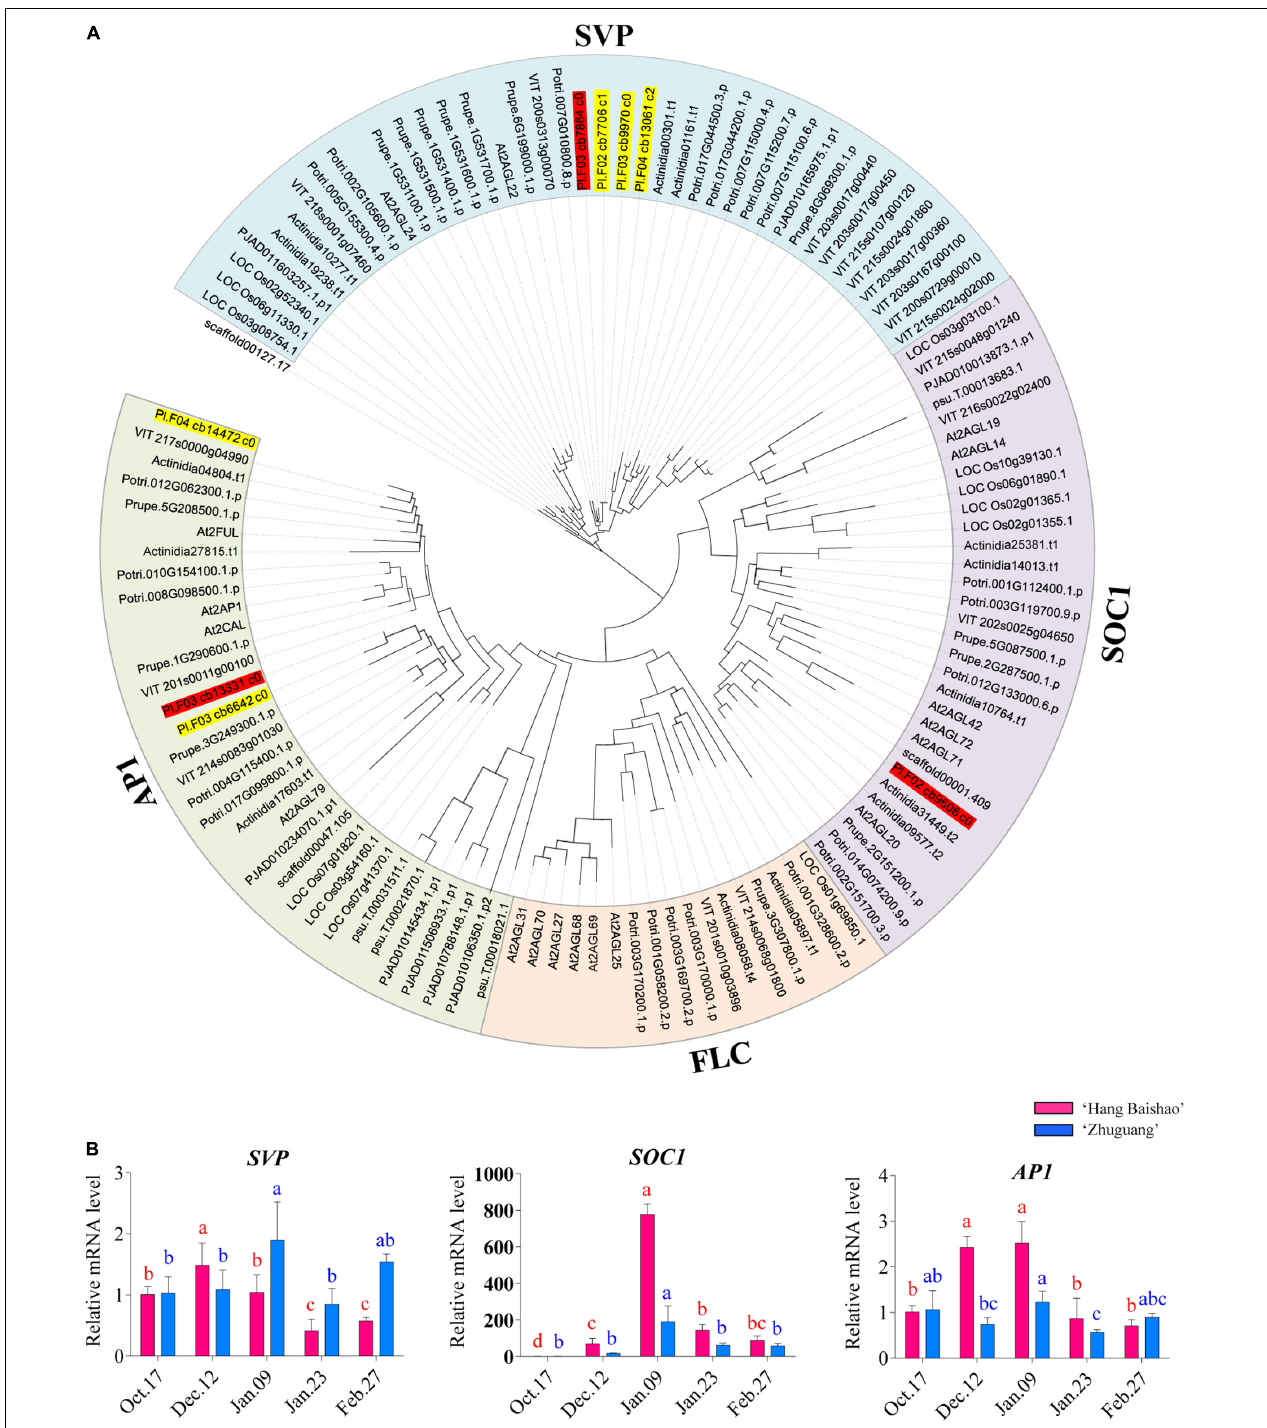
FIGURE 5 | Phylogenetic analysis of the four MIKC C -type MADS-box genes in P. lactiflora with its homologs from the other plants and expression patterns of key MADS-box genes in the two cultivars during bud dormancy. (A) Phylogenetic analysis of MADS-box gene family in P. lactiflora and homologs from the other plants. The tree was generated after multiple sequence alignment using MAFFT and the ML method. The number at each node indicates the percentage of bootstrapping of a 1,000 replications. Scale bar = 0.05. The P. lactiflora MADS-box genes were marked with red and yellow colors, and the genes for qRT–PCR were marked with red color. The full names of the species were shown in the main body of the text. (B) Expression patterns of key MADS-box genes in the two cultivars during bud dormancy. Error bars represent standard deviation from three biological replicates and different letters indicate significant differences ( P < 0.05). Differences were compared among different move dates for each